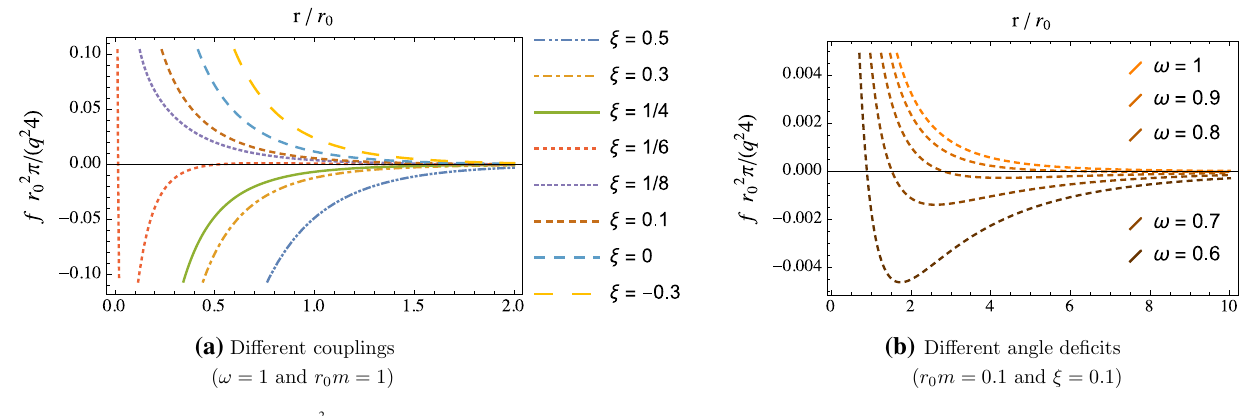
Fig. 5 Dimensionless self-force